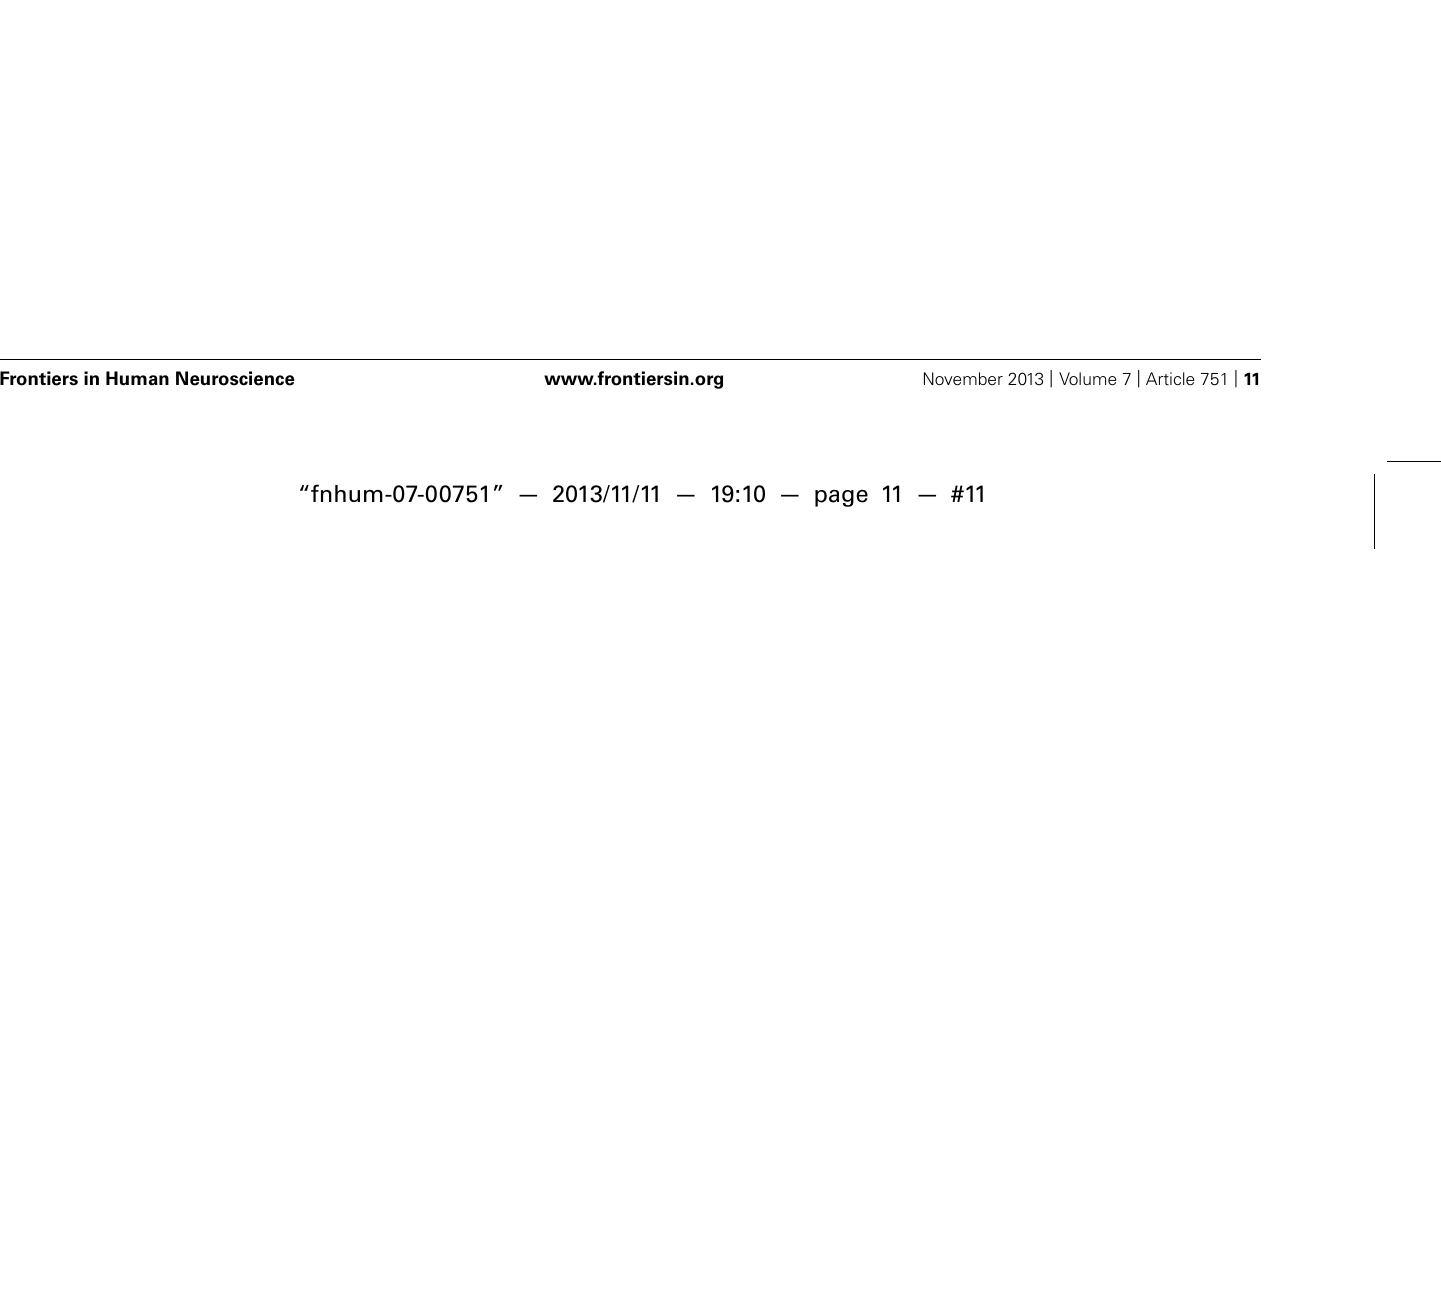
FIGUREA1 |Artifact rejection fromTMS-EEG data by using independent component analysis in a typical participant. (A) Averaged EEG waveforms in no-TMS stop trials (left panel), stop trials with contralateral-TMS at − 500 and 0 ms (middle and right panels) recorded from 61 surface electrodes. (B) Averaged independent component (IC) waveforms and their projection maps in no-TMS stop trials (left panel), stop trials with contralateral-TMS at